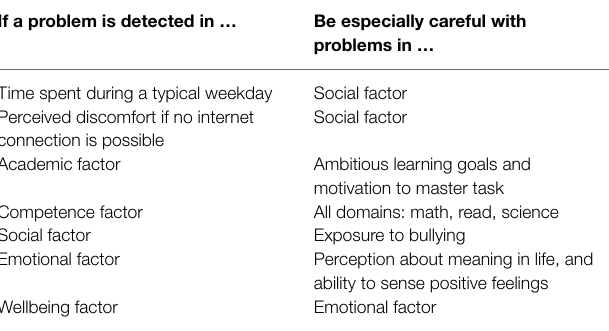
TABLE 11 | Summary of relevant practical